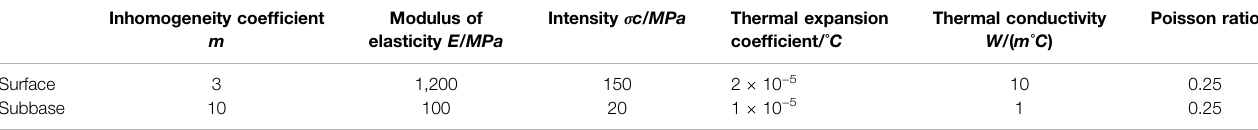
TABLE 1 | Material mechanical